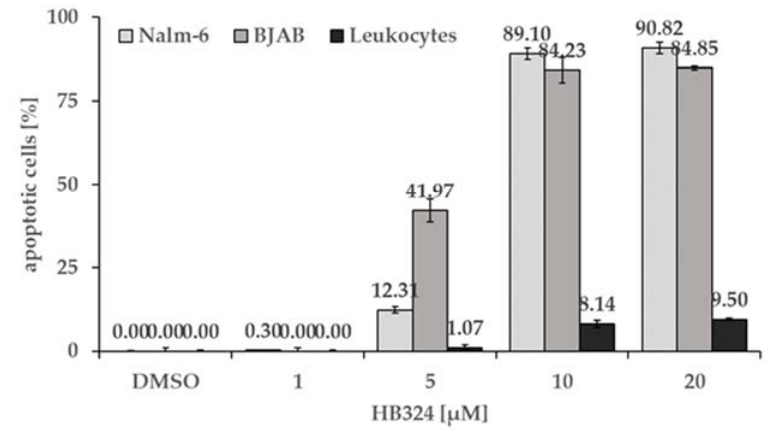
Figure 6. Nalm-6 cells, BJAB cells, and human leukocytes were treated with different concentrations of the substance. Solvent treated cells (0.5% DMSO) served as the control. All cells were incubated for 72 h. Then, induction of apoptosis was measured by flow cytometric analysis of cellular content. Values are given as % of cells with hypodiploid DNA as mean values ± SD (n = 3).